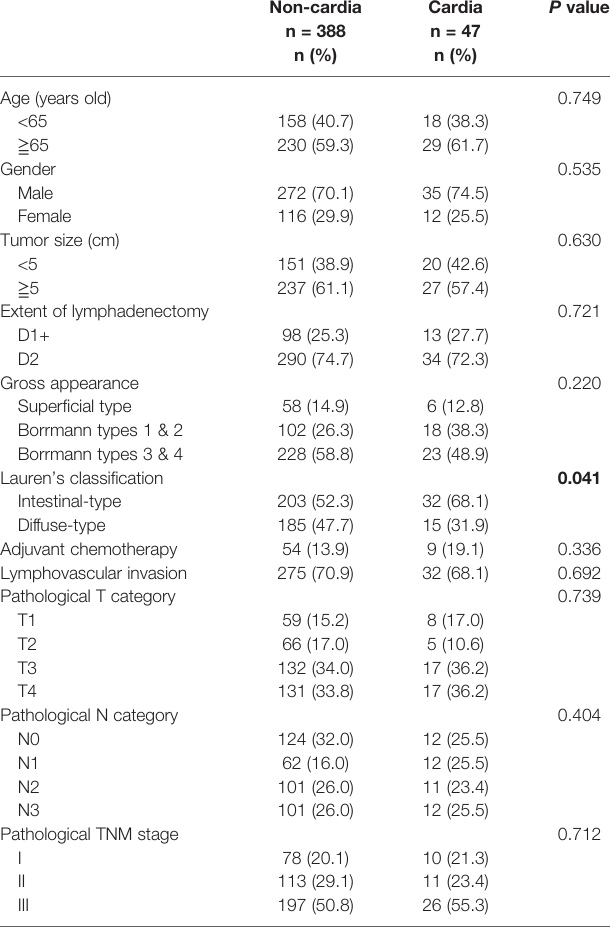
TABLE 1 | Clinical pro fi le between cardia and non-cardia GC patients. Non-cardia